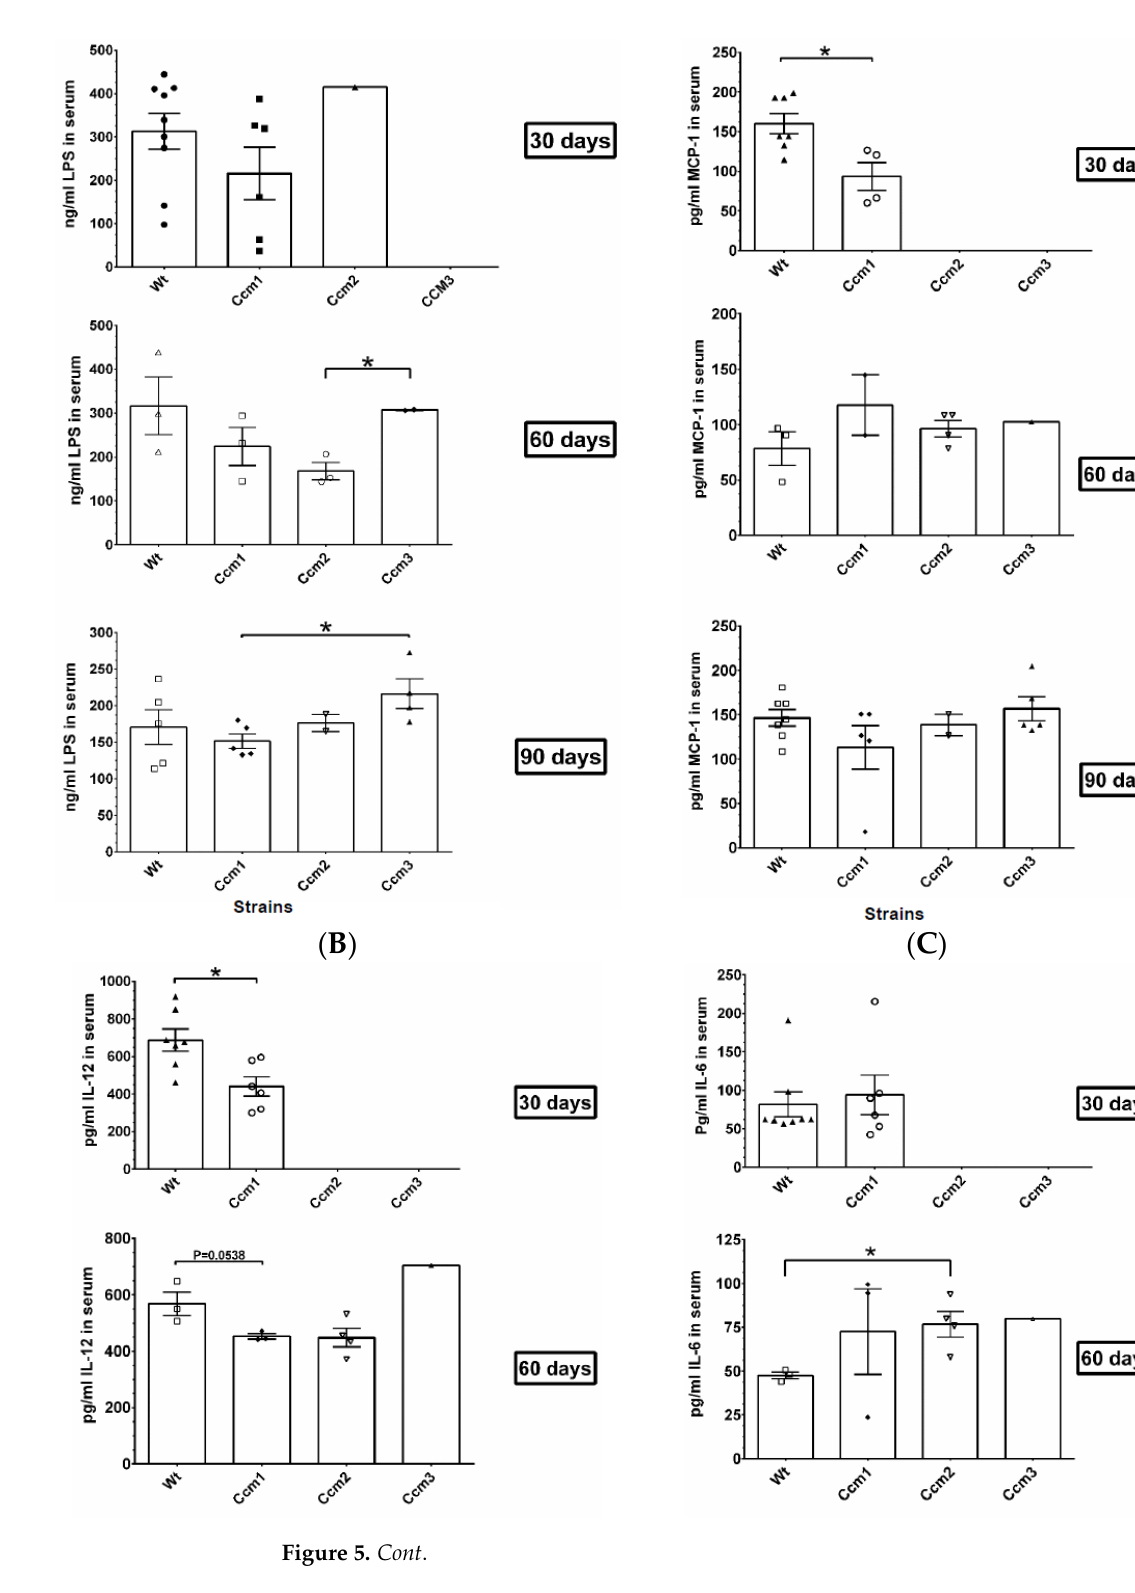
Figure 5. The disrupted BBB is not caused by local inflammatory reactions in Ccms mutant mice. ( A ) Monocytes, neutrophils, large peritoneal macrophages (LPM), and small peritoneal macrophages (SPM) within the peritoneal cell populations were collected through peritoneal lavage. Quantifica ‐ tion of percentage of ( I ) monocytes (CD45.2 + CD11b+ Ly6G ‐ Ly6Chigh), ( II ) neutrophils (CD45.2 + CD11b+ Ly6CintLy6Ghigh), ( III ) LPM (CD45.2 + CD11b+ Ly6G ‐ Ly6C ‐ F4/80hiMHC ‐ IIlo), and ( IV )